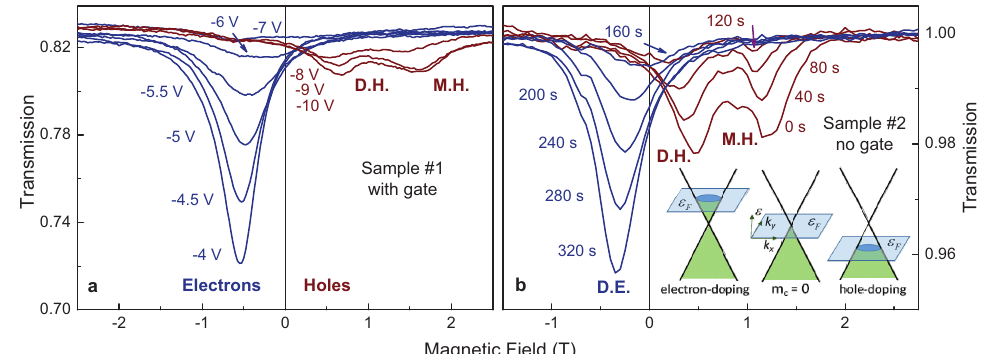
Figure 1. Magneto-transmission of a circularly polarized light in HgTe quantum wells with critical thickness at T = 1.8K and ν = 950GHz. ( a ) Sample #1 with gate (gate voltage is given at curves). ( b ) Sample #2 without gate. The charge density here is varied via light illumination with illumination time as indicated. Negative and positive magnetic fields correspond to negatively- and positively- charged quasiparticles, respectively. Acronyms: D.E.—Dirac electrons, D.H.—Dirac holes, M.H.— massive holes (see text for details). The inset in ( b ) demonstrates schematically the expected Fermi surface for different doping